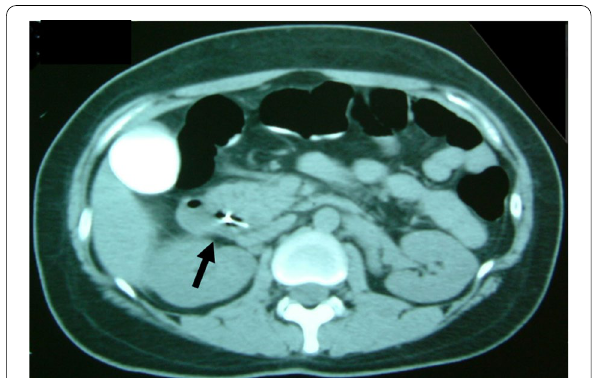
Fig. 3 Abdominal CT. A computed tomography (CT) scan showing the burst balloon located at the site of the biliary sphincter. The arrow indicates the burst balloon of the EBD catheter at the site of the biliary